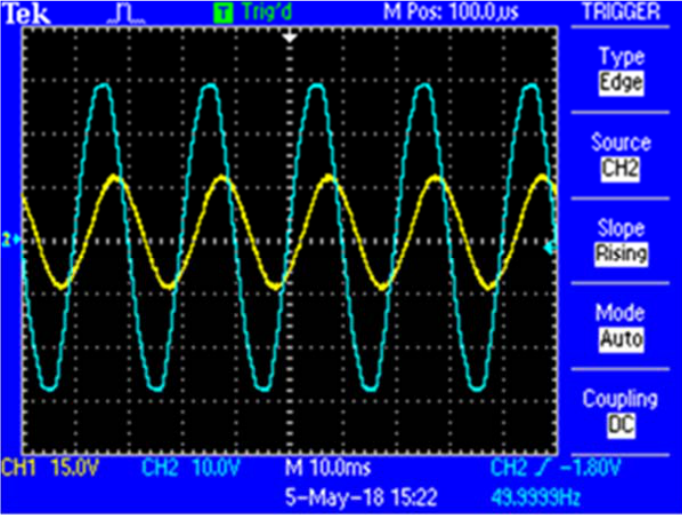
Figure 11. PMSM stator’s voltage and current oscillograms with 360 V to PMSM input applied.